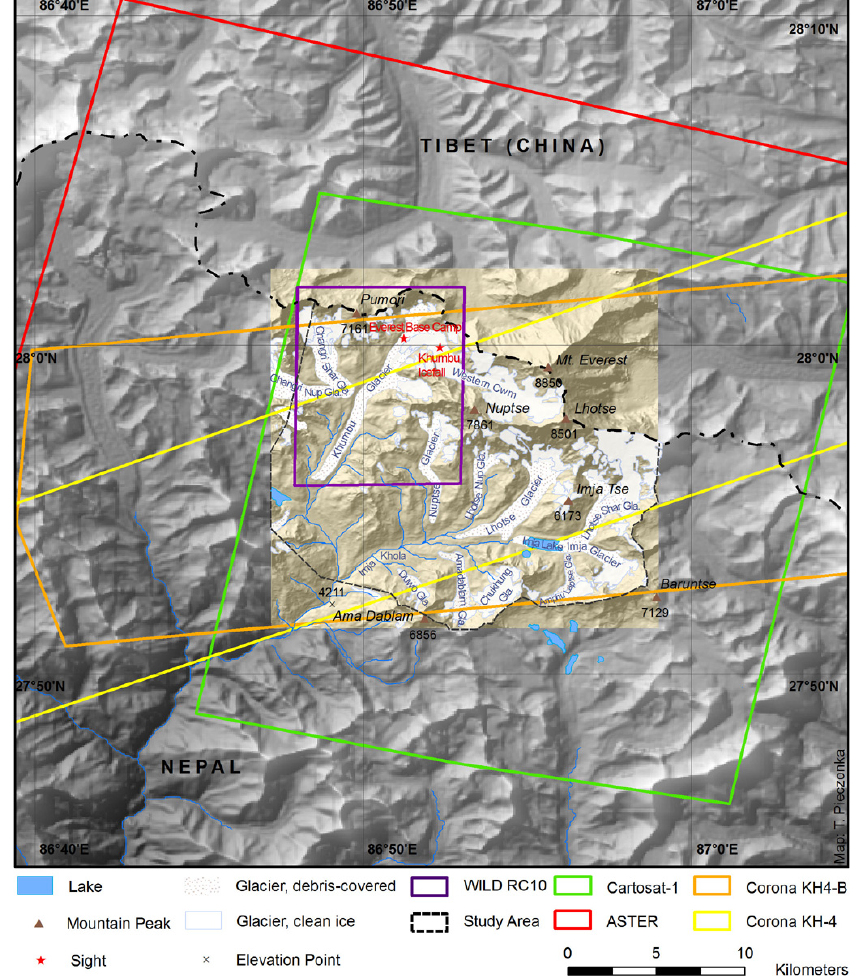
Fig. 1. Study area; location, names and debris-covered portion of the glaciers in the study area, coverage of the utilized satellite data. Background: SRTM3 CGIAR, Vers. 4, study area: ASTER DTM; glacier outlines based on Bolch et al.